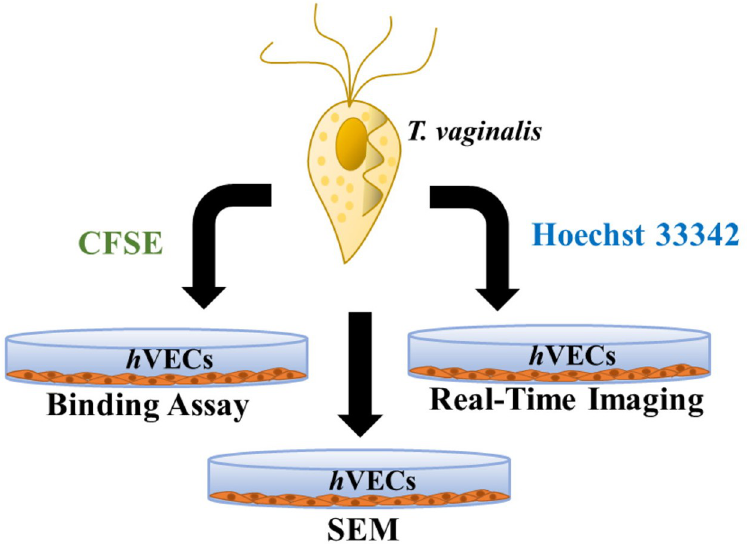
Fig 1. A platform to study the interactions between T . vaginalis trophozoites and human epithelial cells. A semi- quantitative binding assay in conjunction with real-time imaging and scanning microscopy (SEM) were applied to study the interactions between T . vaginalis and human urogenital tract epithelial cells. For the binding assay or real- time microscopy, trophozoites were labeled with CFSE or Hoechst 33342, respectively, while non-labeled trophozoites were explored for SEM. At defined intervals, unbound trophozoites were removed and the adherent trophozoites were fixed for microscopic examination.